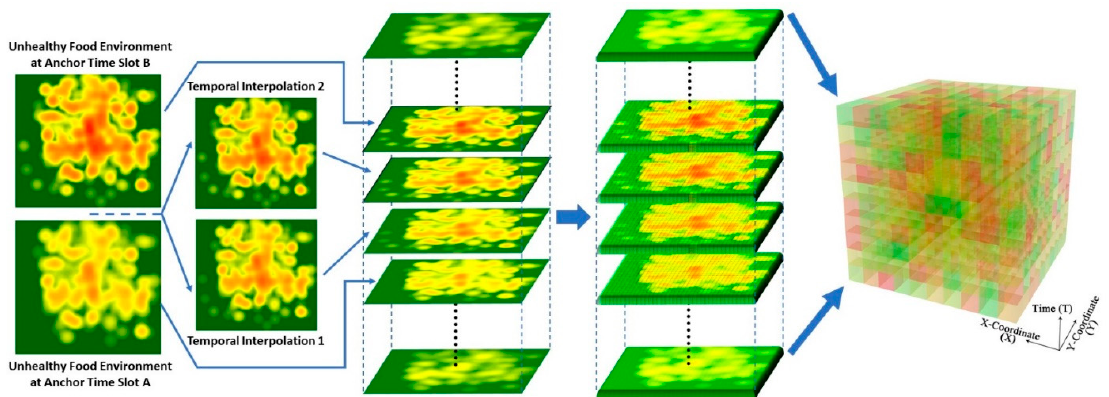
Figure 4. The process of the temporal interpolation and the generation of the 3-D environmental context cube with food environment layers.